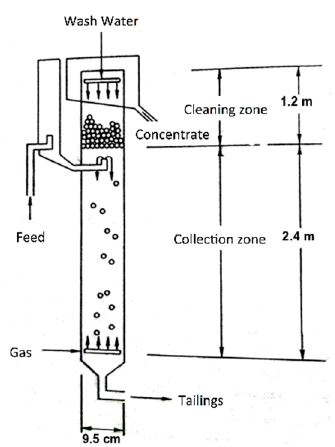
Figure 1. Schematic representation of the flotation column used in this study.